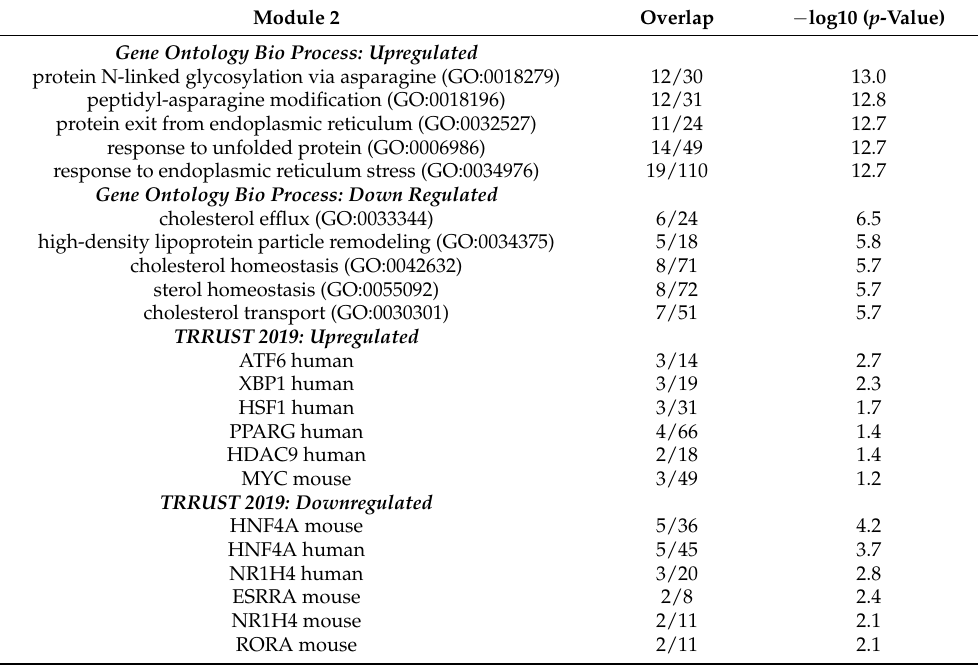
Figure 5. Gene modules (M0—M5) associate with distinct combinations of metabolic traits in male F2 mice. Size and color correspond to the correlation coefficient. * p -value < 0.05. Table 3. Top gene sets ranked by p -value for modules 2 and 3 using EnrichR gene set enrichment analysis and the Gene Ontology Bio Process and TRRUST